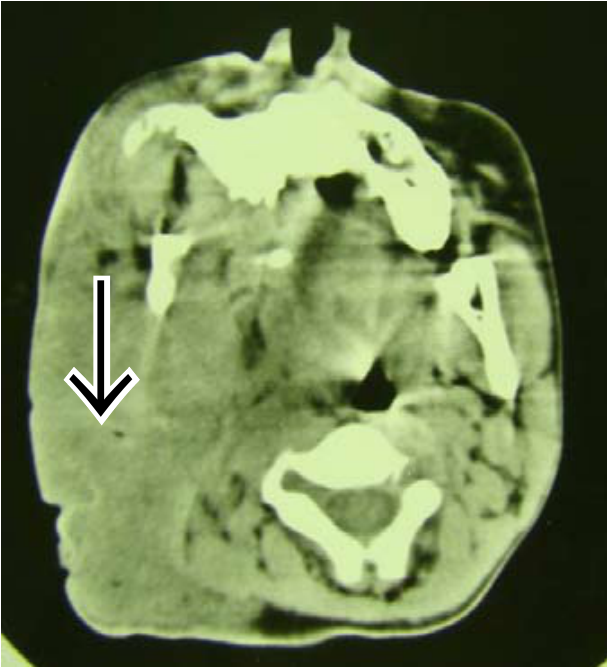
Fig. 4. Axial CT scan of the skull base showing a large plexiform neurofibroma on the right – note the characteristic poorly delineated diffusely infiltrating mass.